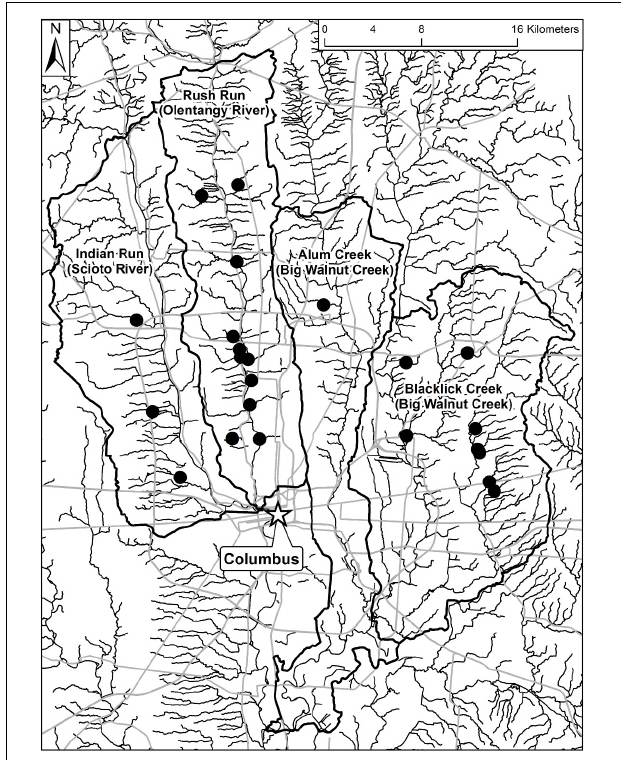
FIGURE 1 | Study-reach locations overlaid on major roadways and waterways and within their major drainage sub-catchments of the Columbus Metropolitan Area, OH, United States. The Scioto River drains 16,822 km 2 , Olentangy River 1,406 km 2 , and Big Walnut Creek 890 km 2 . The Blacklick, Rocky Fork, and Alum Creek sub-catchments drain 159, 49, and 320 km 2 ,